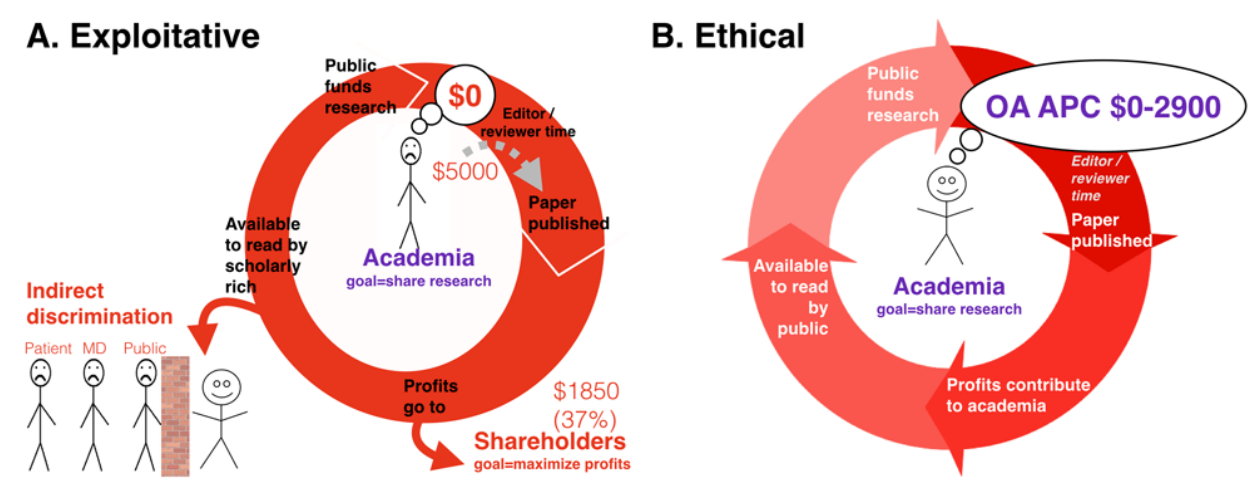
Figure 1. Two routes to the publication of a journal article. ( A ) The exploitative route exploits researchers and academia and discriminates against who can read research because only individuals at those institutions that can afford journal subscriptions can read the research. ( B ) The ethical route keeps profits inside academia and does not discriminate against who can read the research. OA=Open Access, APC=Article Processing Charge. Note: the APC range is taken from ethical examples in the field of animal behavior (see Table 1).